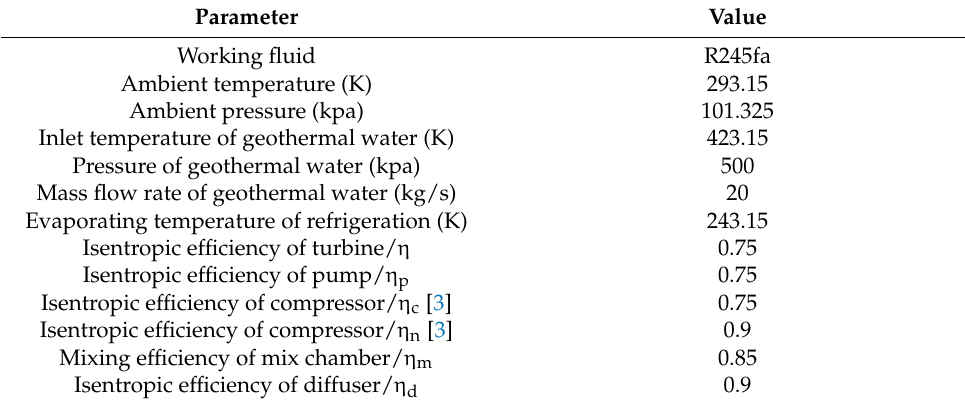
Table 8. Initial condition of